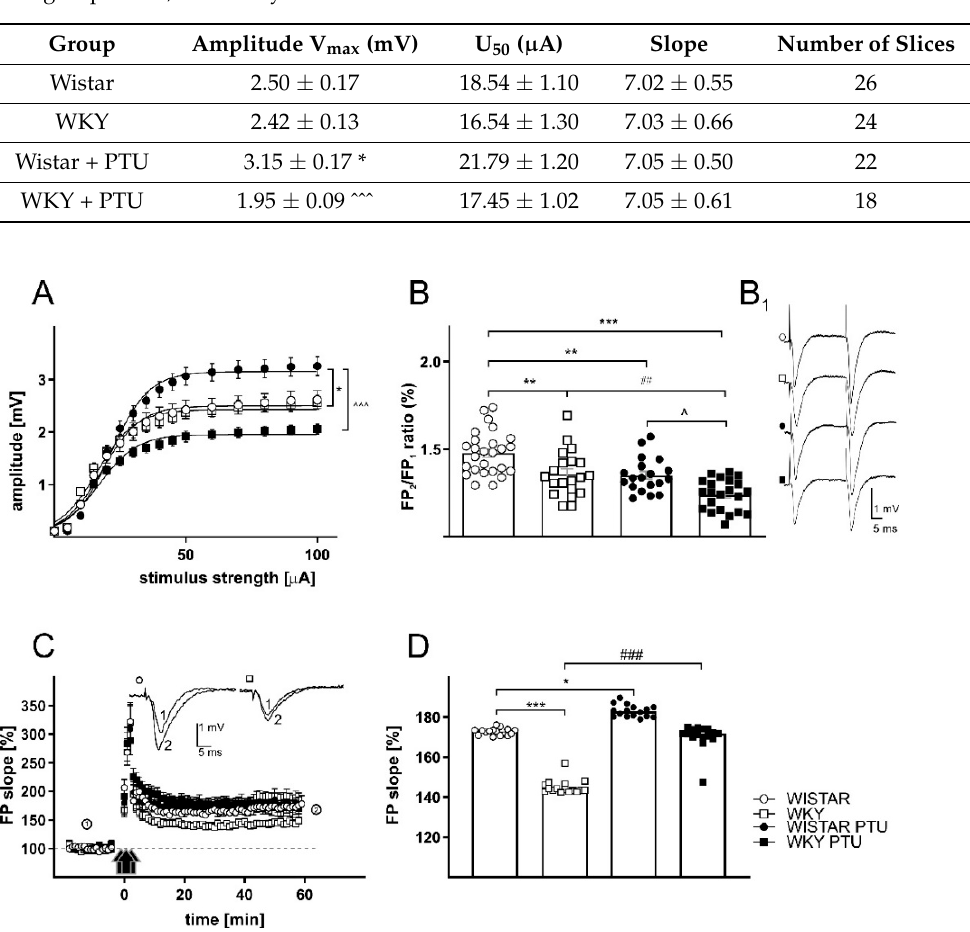
Figure 2. The effects of strain and PTU treatment (filled symbols) on the relationship between the stimulus intensity and amplitude of field potentials ( A ), paired-pulse ratio ( B ), examples of individual field potentials (FPs) evoked by paired stimuli ( B 1 ) and long-term potentiation (LTP) recorded in the CA1 hippocampal area of Wistar (circles) and WKY (squares) rats ( C , D ). The graph shows plots of the mean amplitudes ± SEM ( C ). Effects of PTU on LTP induced by high-frequency stimulation (HFS) in hippocampal CA1 areas in slices prepared from Wistar rats (filled circles) and WKY rats (filled squares). The insets show examples of FP slopes recorded at the indicated times before (1) and after (2) PTU administration. The mean slopes of FPs recorded between 45 and 60 min after HFS in control slices, and slices prepared from PTU-treated animals are shown. The results are expressed as the mean ± SEM. * p < 0.05 vs. the control group (Wistar rats), ** p < 0.01 vs. the control group (Wistar rats), *** p < 0.001 vs. the control group (Wistar rats), ## p < 0.01 vs. the WKY, ### p < 0.001 vs. the WKY group, ^ p < 0.05 vs. Wistar PTU group, ^^^ p < 0.001 vs. Wistar PTU group. n = 6–8.